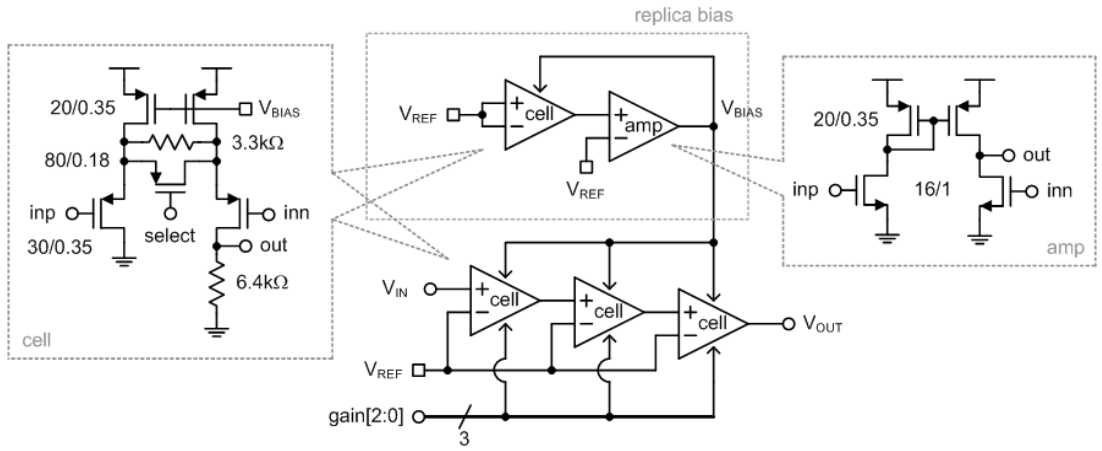
Figure 13. Architecture of the implemented PGA.